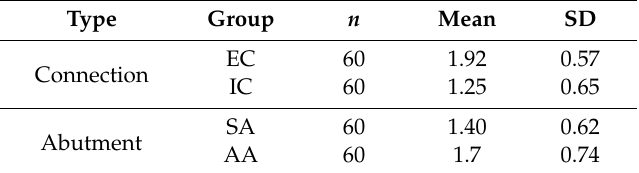
Table 5. Means and standard deviation (SD) misfit values (micrometers) for connections regardless of abutments and torque, and abutments regardless of connection and torque (EC: external connection; IC: internal connection; SA: straight abutment; AA: angulated abutment).